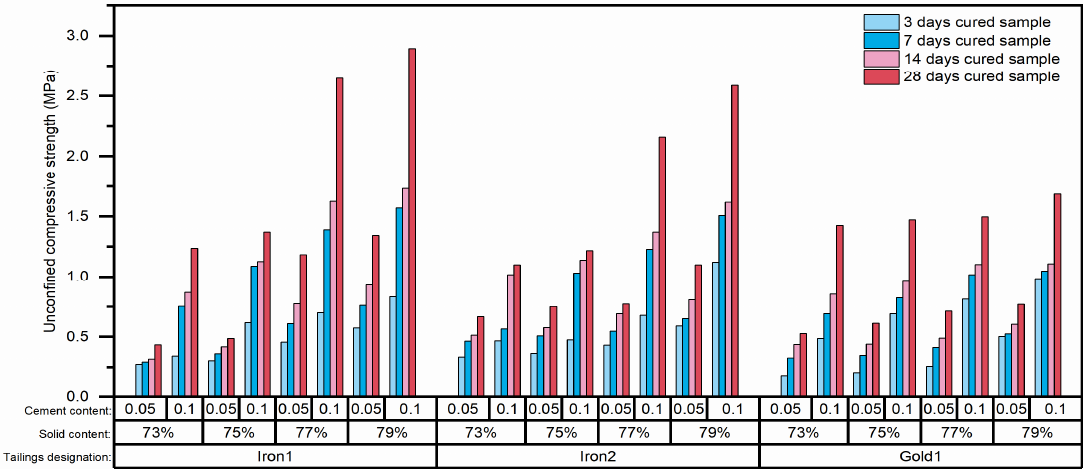
Figure 4. Unconfined compressive strength values of CTB samples.